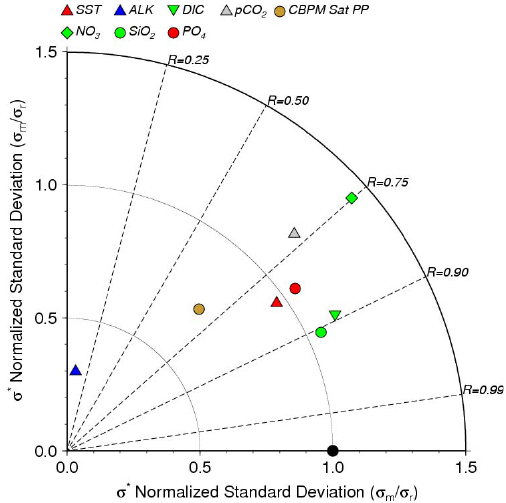
Fig. 6. Taylor diagram showing normalized standard deviations ( σ *) and correlation coefficients ( R) for model versus reference values, consisting of all measured variables from different available sources. All comparisons were done using surface values, except for PP which is a vertically integrated value. The black circle shows the result that would be obtained for a perfect fit between model and data, e.g., identical standard deviations and R